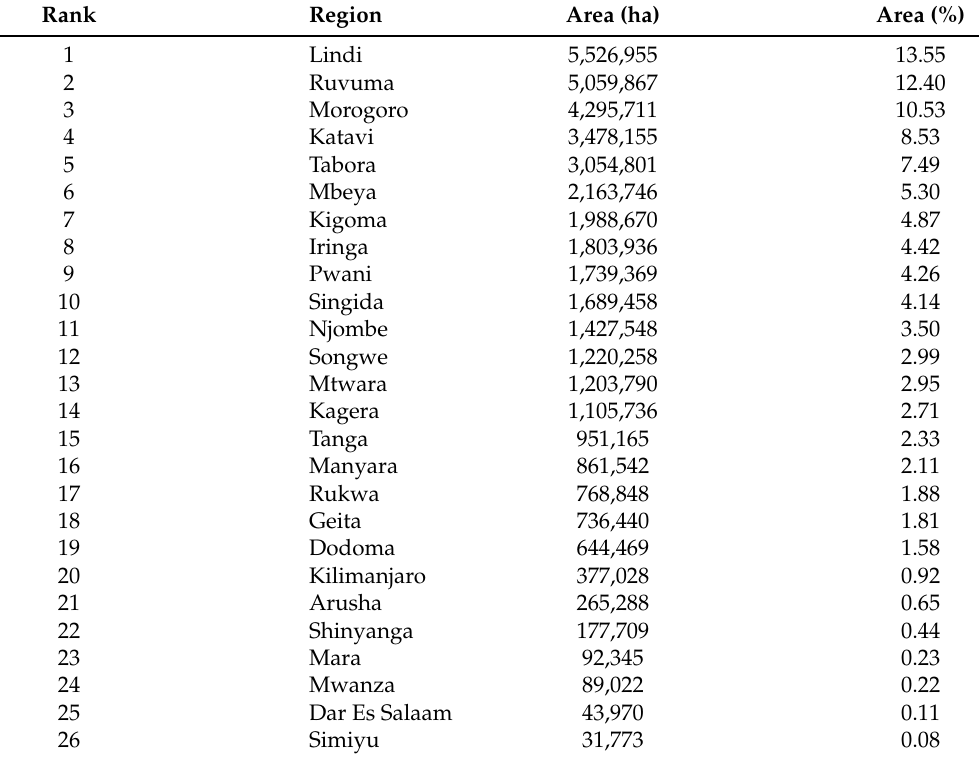
Table 6. Summarised forest extent using a map ranked by regions.